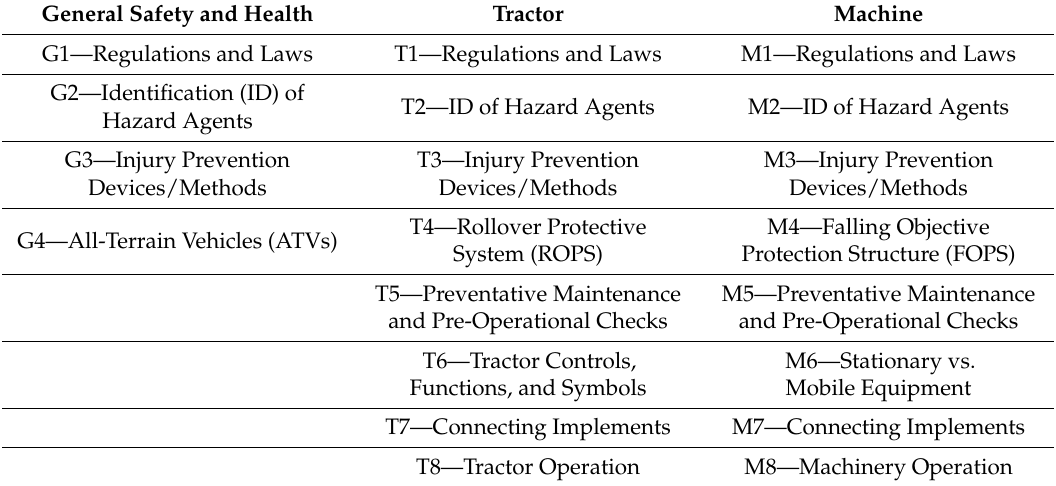
Table 2. Secondary Sub-Classification System.